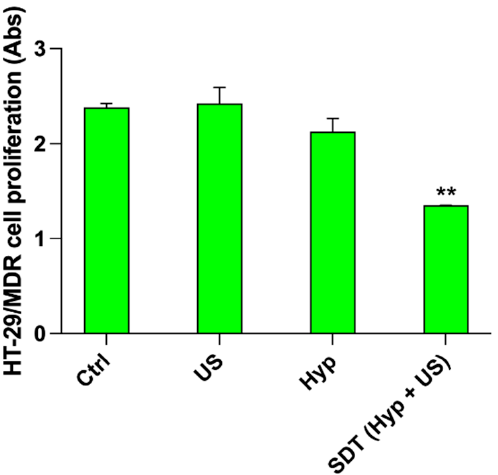
Figure 9. Effects of Hyp-mediated sonodynamic treatment on HT-29/MDR cell proliferation. HT-29 cells were incubated for 24 h with 0.1 µ M Hyp and then exposed to US (1.5 W/cm 2 at 1.5 MHz, continuous wave mode for 5 min). Cell proliferation was then evaluated by WST-1 assay after 48 h. Statistically significant difference versus untreated cells: ** p ≤ 0.01 ( n = 3).